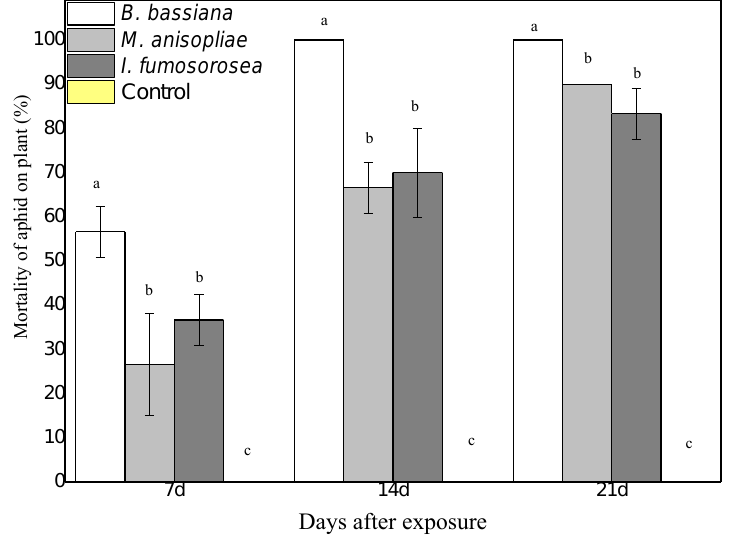
Figure 3. Mortality of M. persicae aphids on the leaves of endophytic plants, following exposure to endophytic entomopathogenic fungi after 7, 14 and 21 days. Mean ± sd values with the same superscript letter are not different in a significant way. (Bonferroni’s test: p < 0.05).